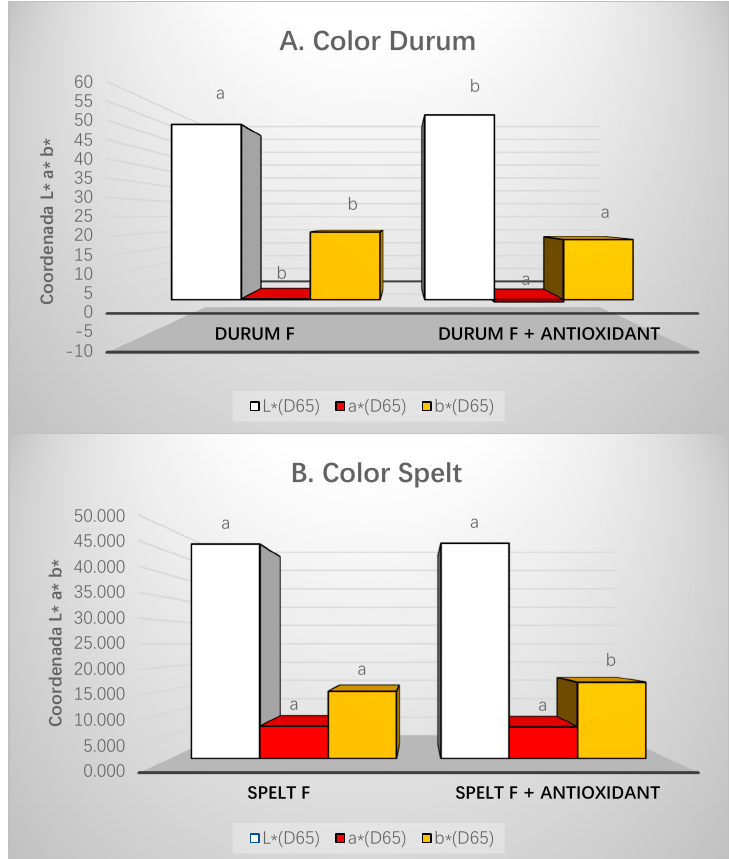
Figure 4. Color parameters in different types of pasta. Distinct letters indicate significant difference ( p < 0.05) among the different parameters between treatments. ( A ) Color Durum; ( B ) Color